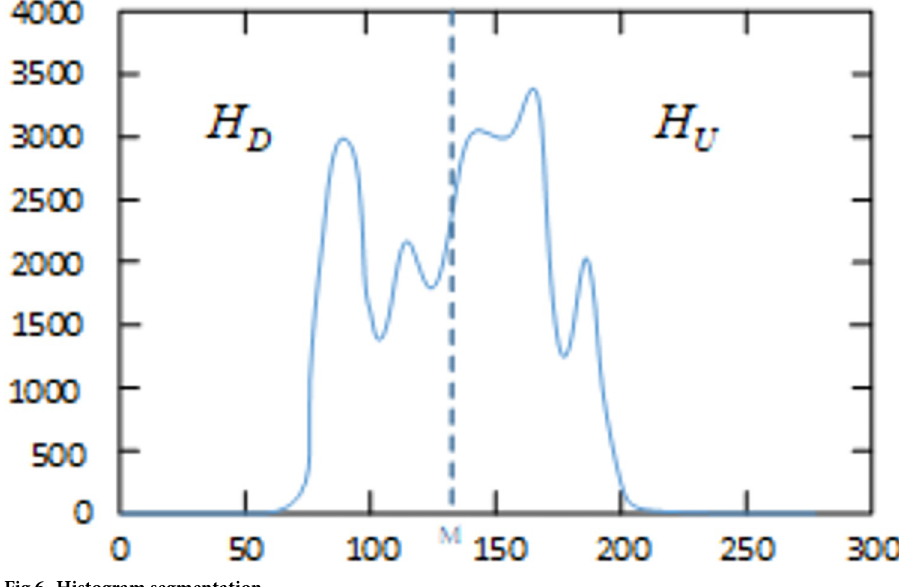
Fig 6. Histogram